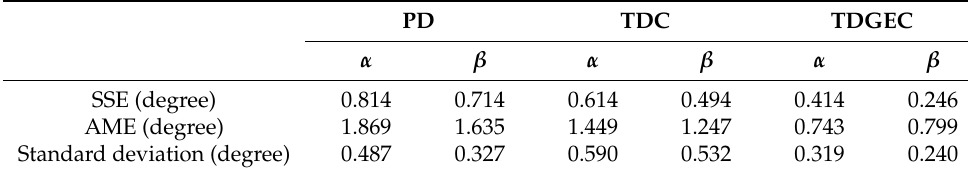
Table 5. The SSE, AME, and the standard